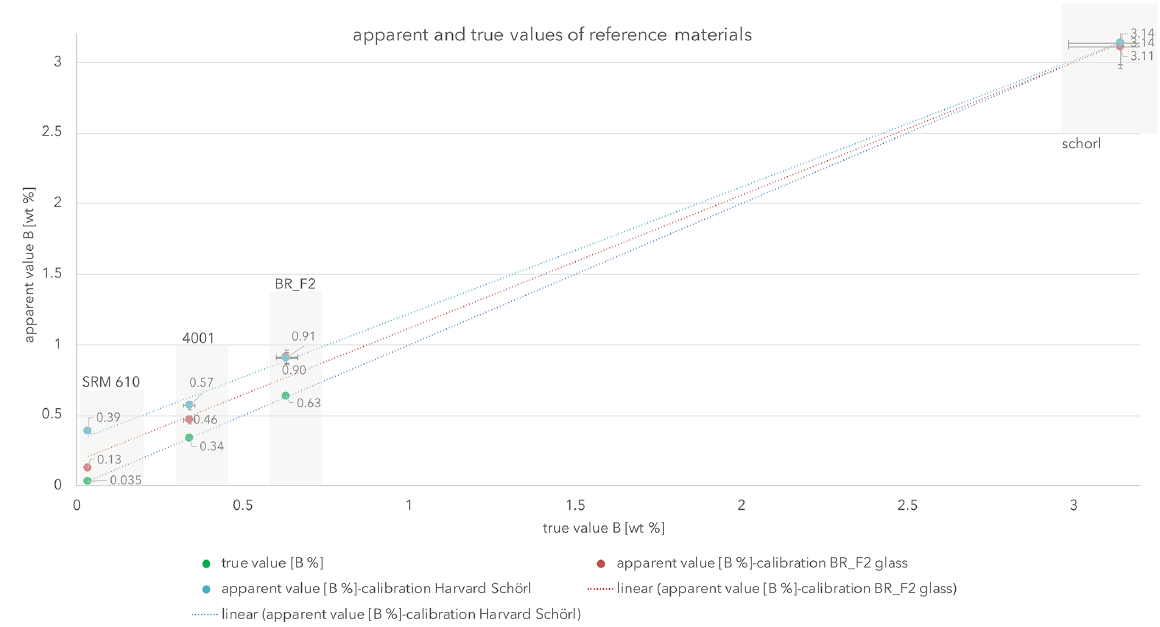
Figure 2. Analytical results of our reference materials (in swaths). Error bars symbolize 5% of